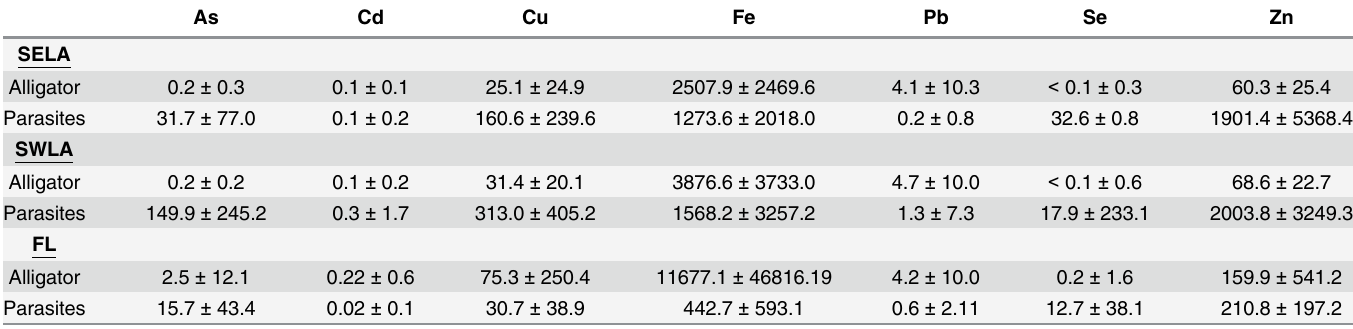
Table 5. Comparison between geographic zones of mean ( ± standard deviation) heavy metal concentrations (mg/kg) from alligators and their